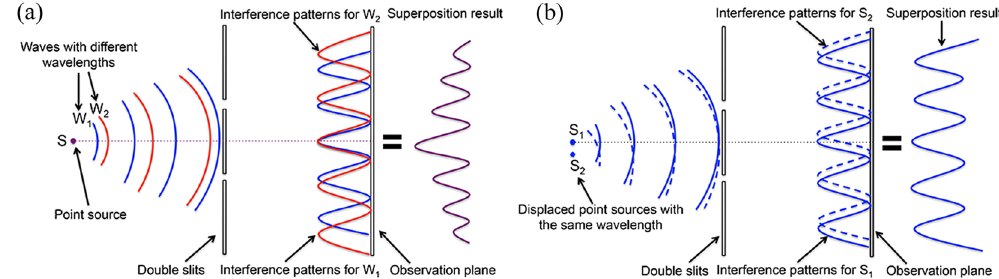
Figure 1. Illustration of the effect of interference patterns on image sharpness for ( a ) a point source emitting different wavelengths (temporal coherence) and ( b ) an extended light source consisting of two identical single- wavelength light sources separated spatially (spatial